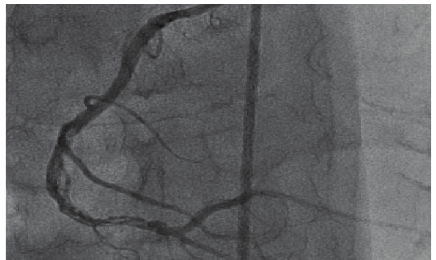
Figure 4: Coronary angiography showed proximal thin channels and distal reanastomosis.